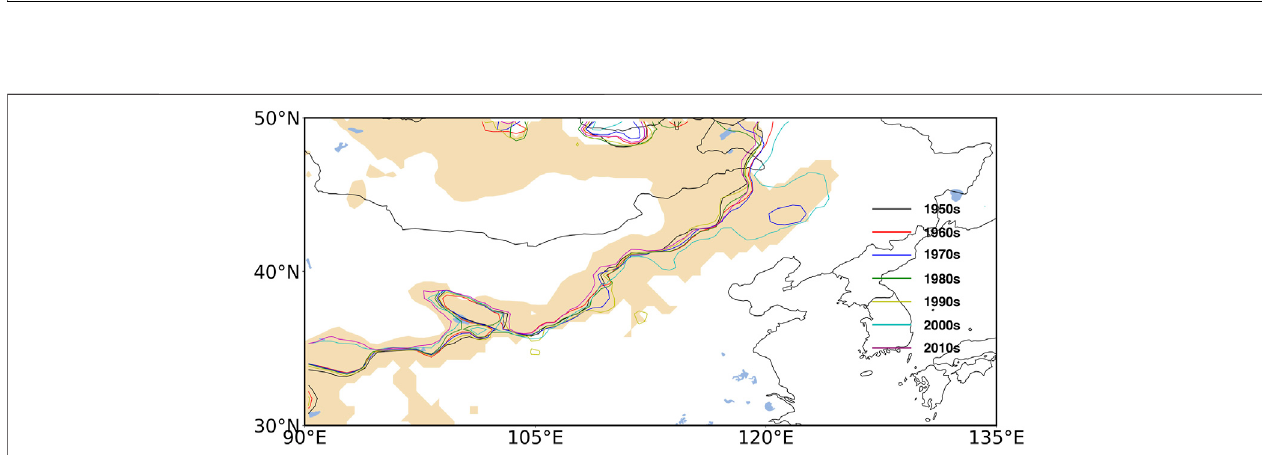
FIGURE 8 | The decadal monsoon edge in the past 70 years. The brown areas represent semi-arid areas.